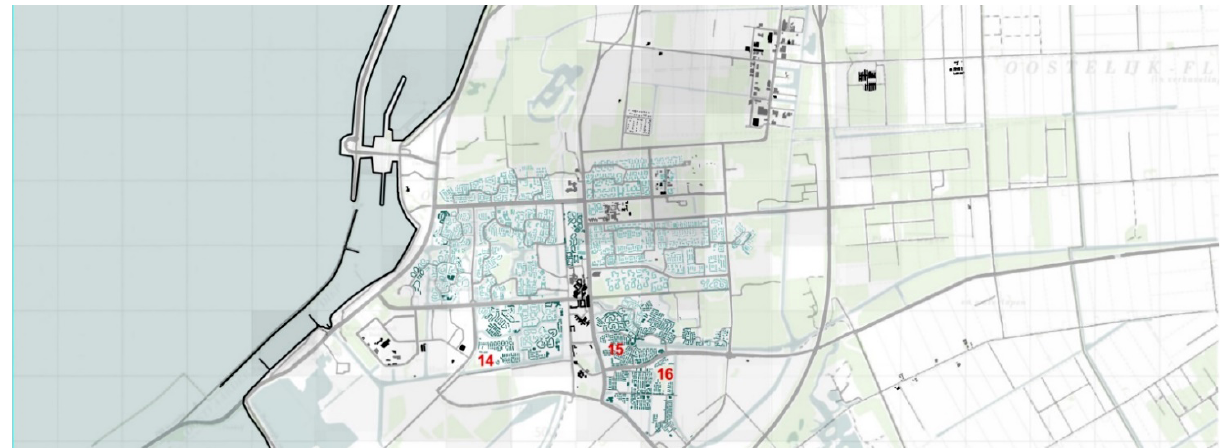
Figure 24. Neighbourhoods that were built between 1980 and 1990. Notes: (14) Schoener, (15) Boswijk and (16) Waterwijk. Source: